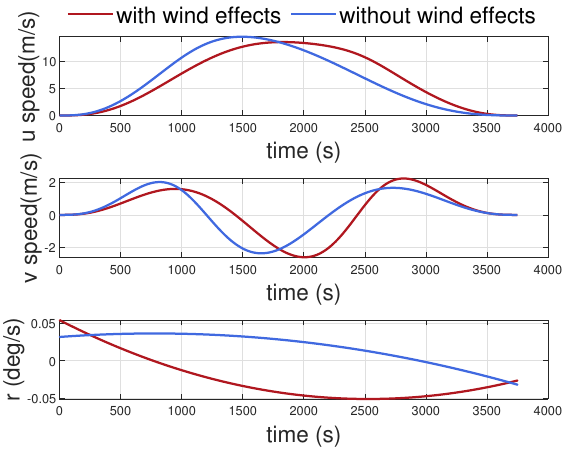
Figure 8. Position, attitude and change rate of the airship. The comparison of horizontal velocity and the yaw angle velocity | r | during the airship’s return phase is shown in Figure 9 and 10. The capacity of the airship angular velocity is of great significance for airship structural stability and stable operation, and represents the attitude change rate. The upper limit of the yaw angle velocity of the airship | ψ | is specified as 0.05 deg/s. With wind effects, the yaw angle velocity r will decrease and then increase reversely. When t = 2500 s, r will decrease again. Without the influence of the wind field, r will decrease the entire time until t = 3000 s, and r will increase in reverse.